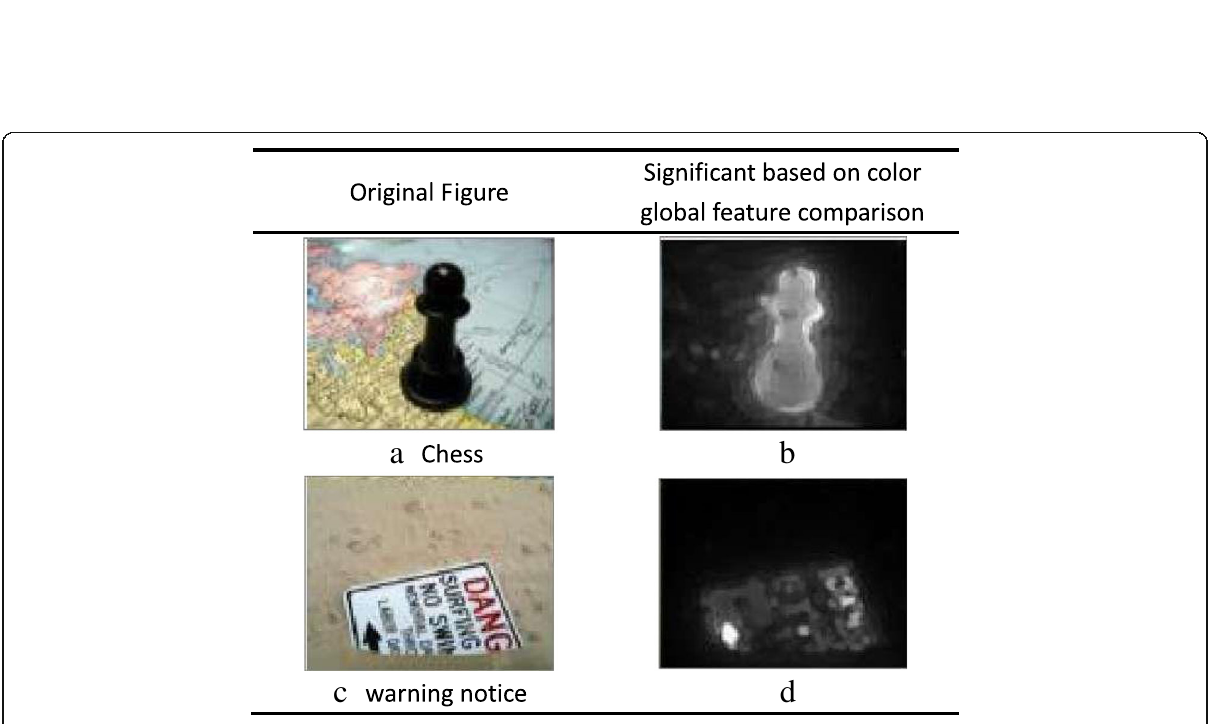
Fig. 7 Examples of super-pixel segmentation. a The comparisons between original images and the corresponding results of the images using super-pixel segmentation. b The details of super-pixel segmentation in the bottom of right corner for Fig. 7( a )